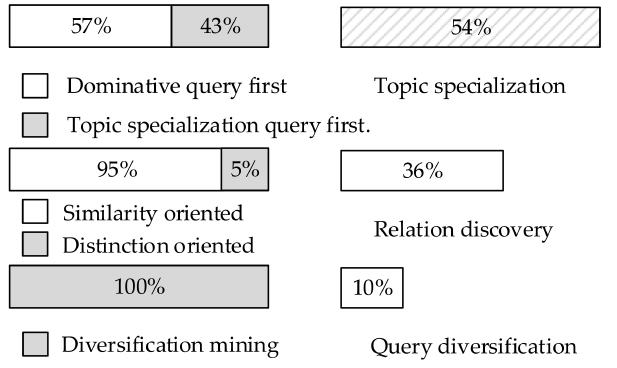
Figure 3. Category and pattern distribution in QCB